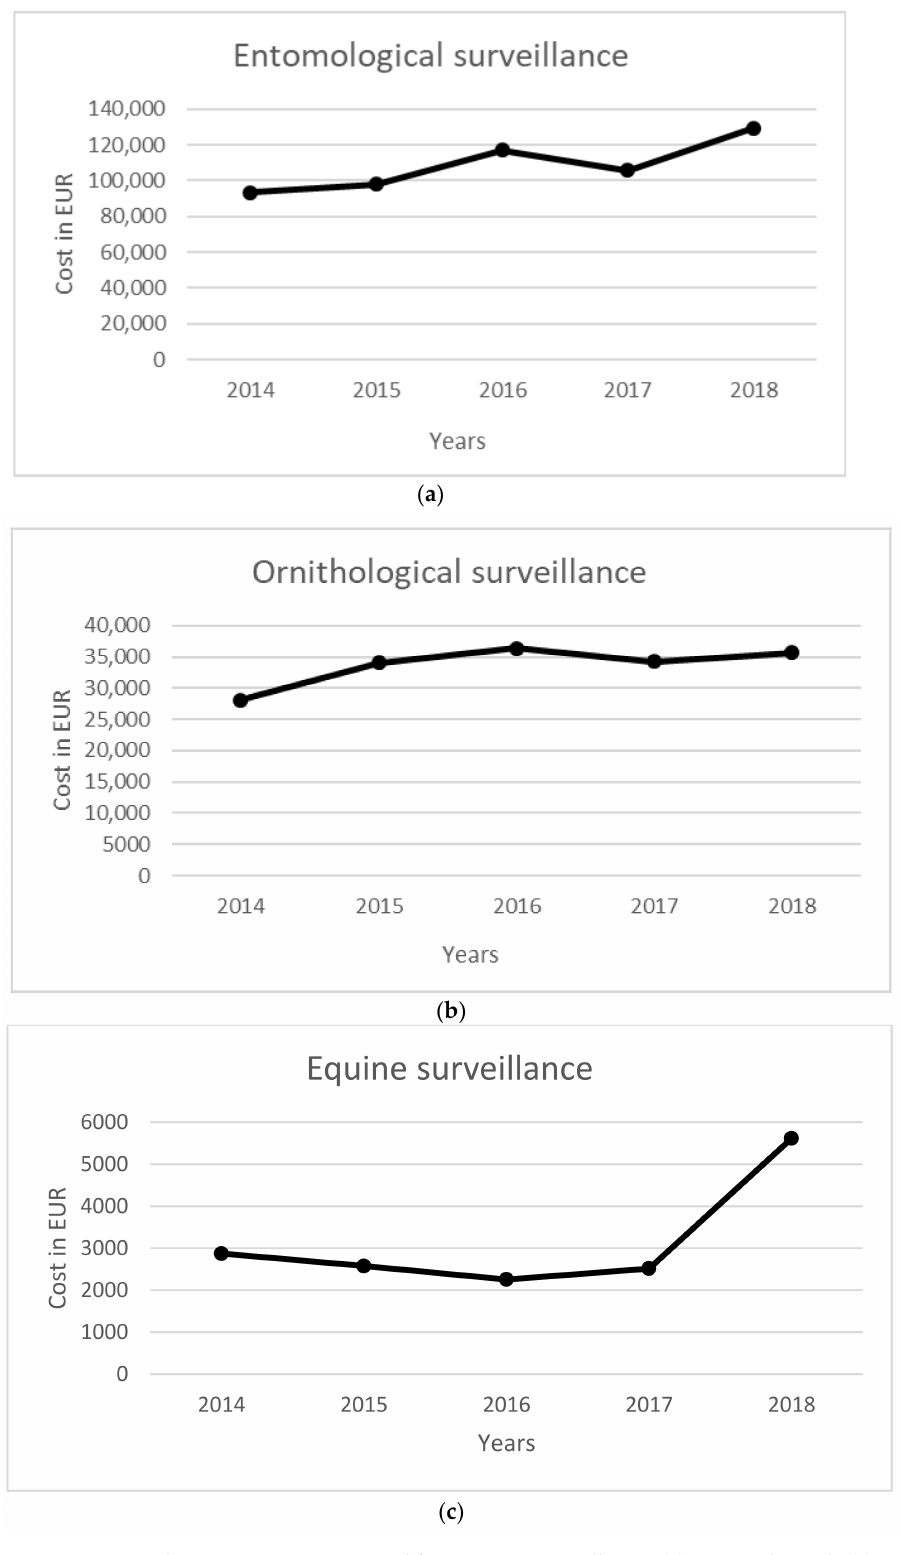
Figure 1. Annual costs per environmental/veterinary surveillance. ( a ) Entomological, ( b ) ornitholog- ical, and ( c ) equine